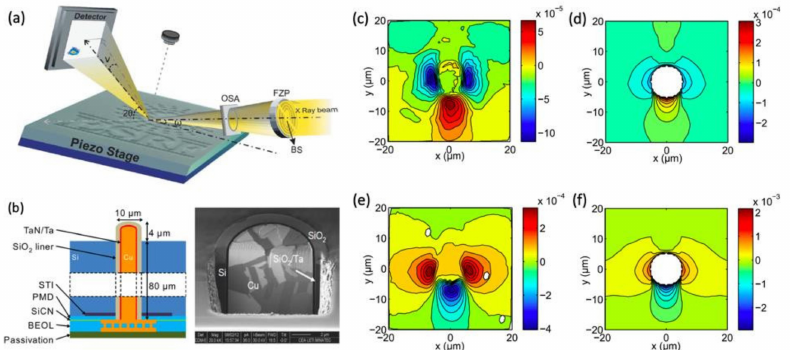
Figure 9. ( a ) Experimental scanning XRD microscopy device on the ESRF beamline ID01 [17]. ( b ) Schematic view and FIB/SEM section of the measured sample. ( c – f ): Two-dimensional measure- ments of the deformation field of Si along the [335] direction, around a Cu via at room temperature ( c ): experiment and ( d ): simulation) and during the in situ annealing at 400 ◦ C ( e ): experiment and ( f ): simulation) [96]. Reproduced from [96] with the permission of AIP